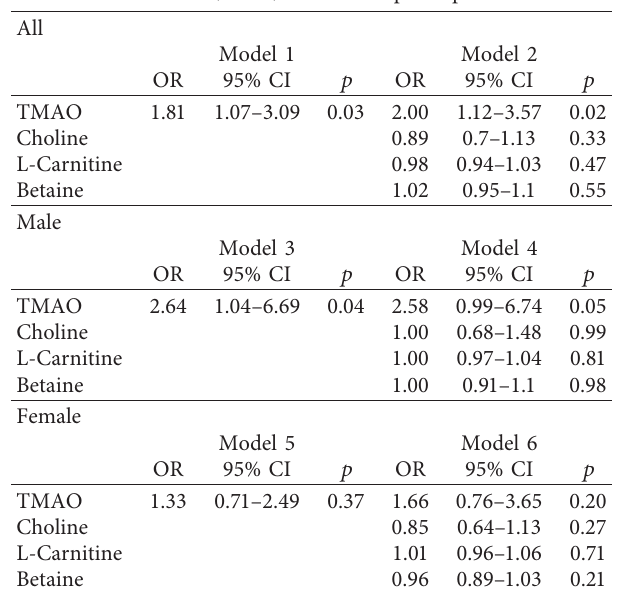
Figure 2: Comparison of plasma TMAO, choline, L-carnitine, and betaine levels between mild artery stenosis and severe artery stenosis. Detected plasma TMAO (a), choline (b), L-carnitine (c), and betaine (d) concentration in mild artery stenosis and severe artery stenosis groups. M: mild artery stenosis; S: severe artery stenosis. Table 2: Association of TMAO, choline, L-carnitine, and betaine levels with CAD in all, male, and female